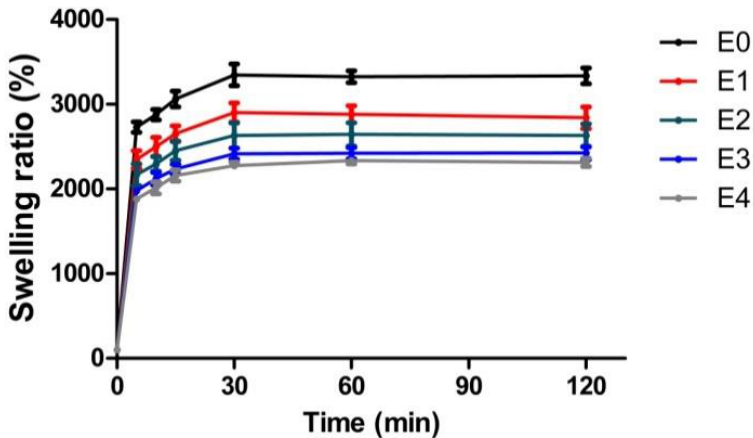
Figure 8. Swelling ratios of the as-prepared ESM/GG hydrogels containing various ESM amounts at different time intervals. Error bars mean the standard deviation (n = 4).